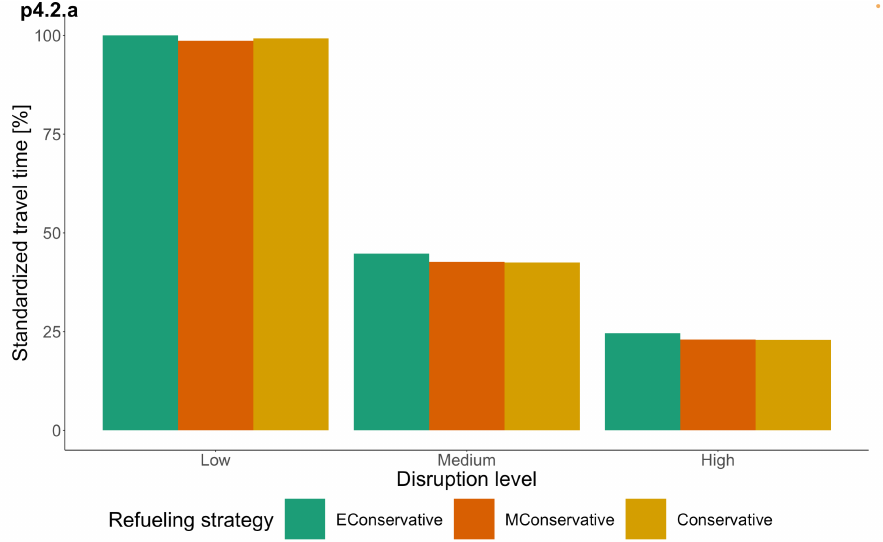
Figure 10. Performance of refueling strategies: normalized travel time of exploration route for instance cluster B. The standardized travel time 100% is equivalent to 57.52